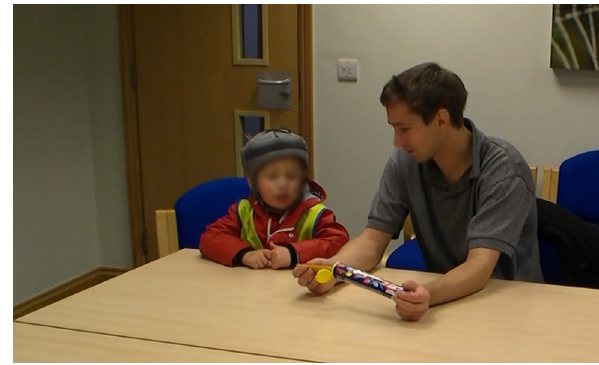
Figure 2: A researcher administering the